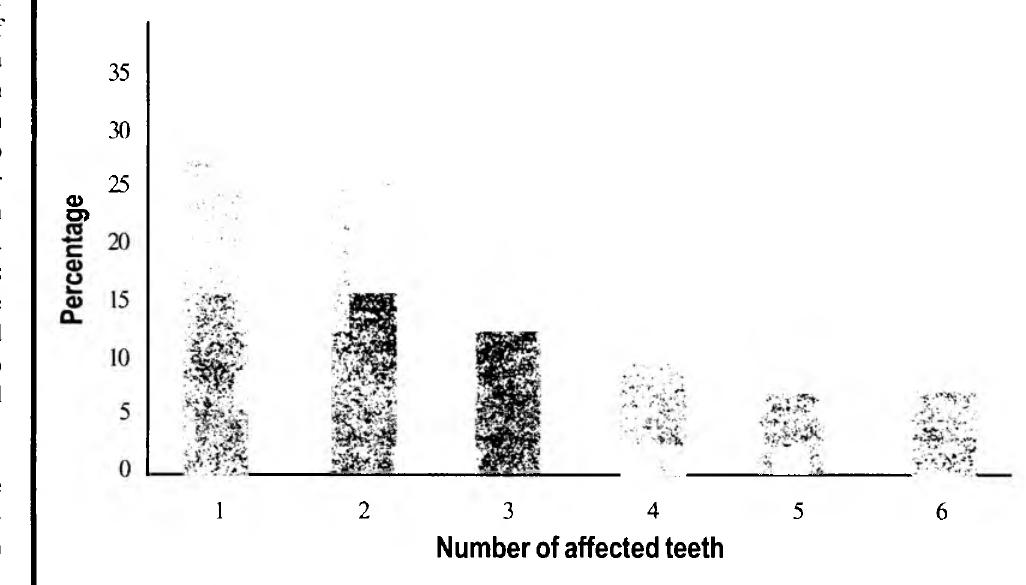
Table 4: Number of affected teeth per child with dental caries (n=36)